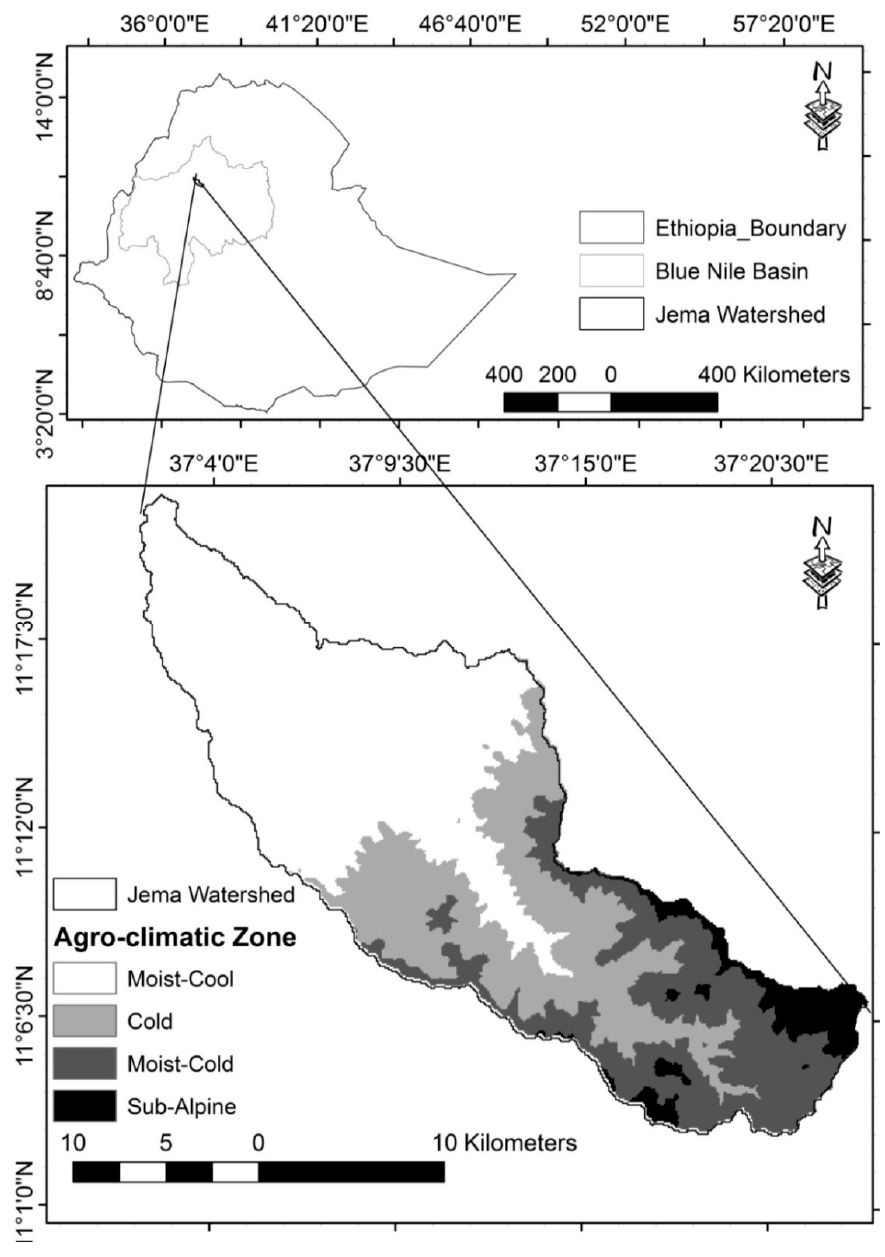
Figure 1. Location map of the agro-climatic (elevation) zones of the Jema watershed. Table 1. Area coverage of the agro-climatic zones (ACZs) of the Jema watershed as computed from the digital elevation model with a 30-m resolution.